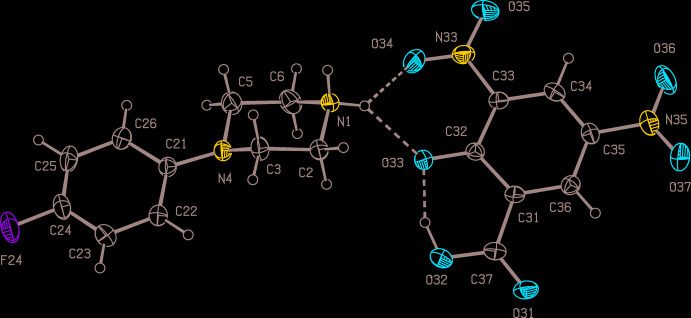
The independent components of compound (I) showing the atom-labelling scheme and the hydrogen bonds (drawn as dashed lines) within the asymmetric unit. Displacement ellipsoids are drawn at the 30% probability level.